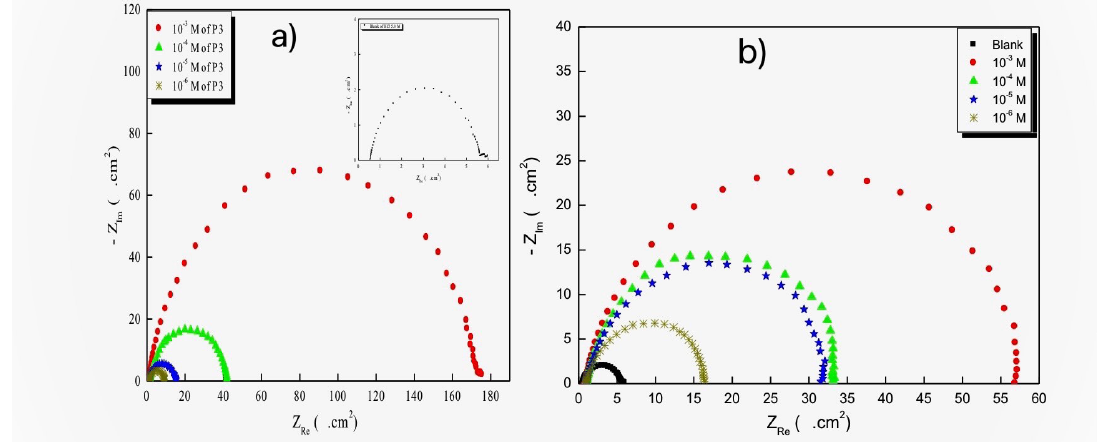
Figure 3. Nyquist impedance diagrams for ordinary mild steel in 5.0 M HCl solution at 298 K containing different concentrations of (a) P3 or (b) P4.